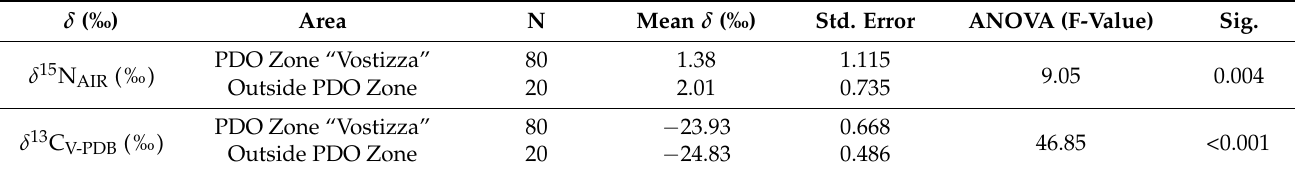
Table 1. One-way ANOVA results (mean values and standard error).